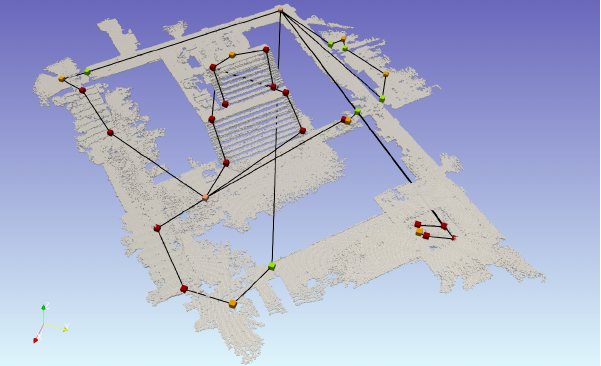
Figure 14. Connectivity network automatically generated from walkable space (red = stair or slope, green = door, orange =